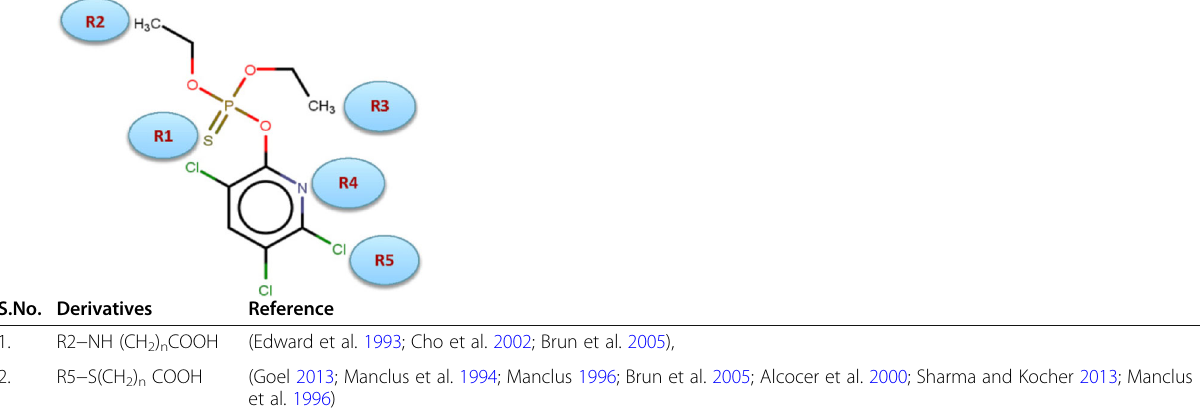
S.No. Derivatives